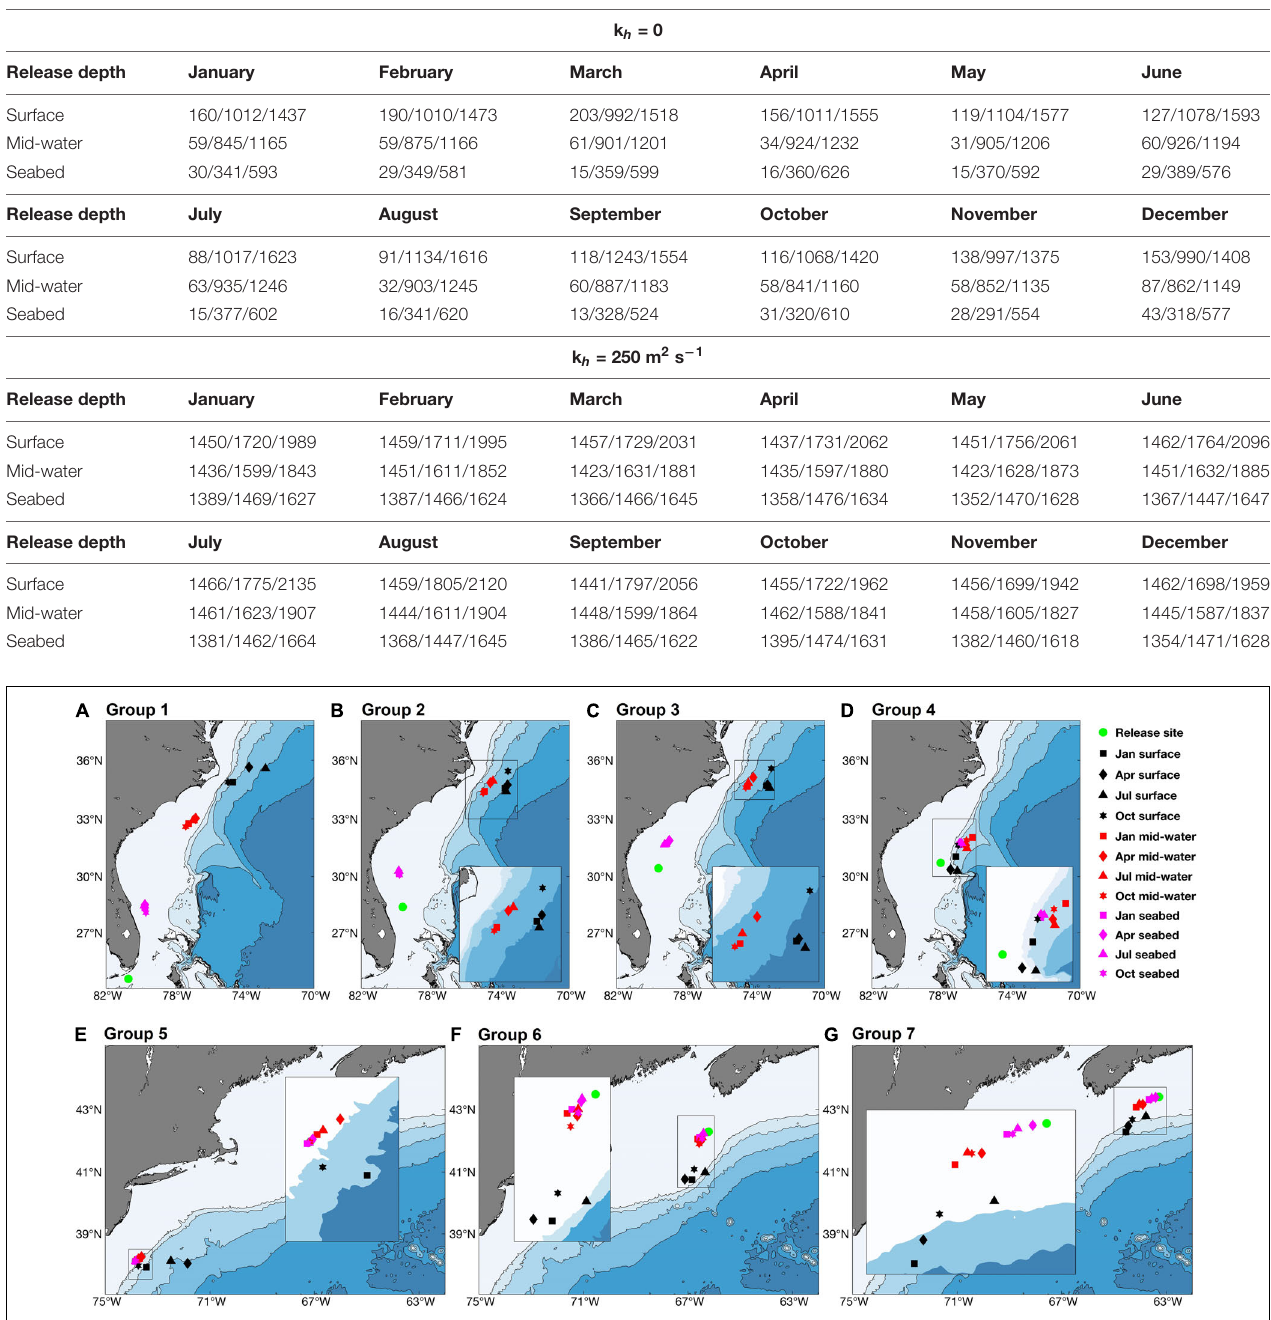
TABLE 3 | Median, 95th percentile and maximum flow distances (km) of particles released at each of three depths, by calendar month and alternative values of diffusivity using long-term averaged monthly currents (1990–2015).